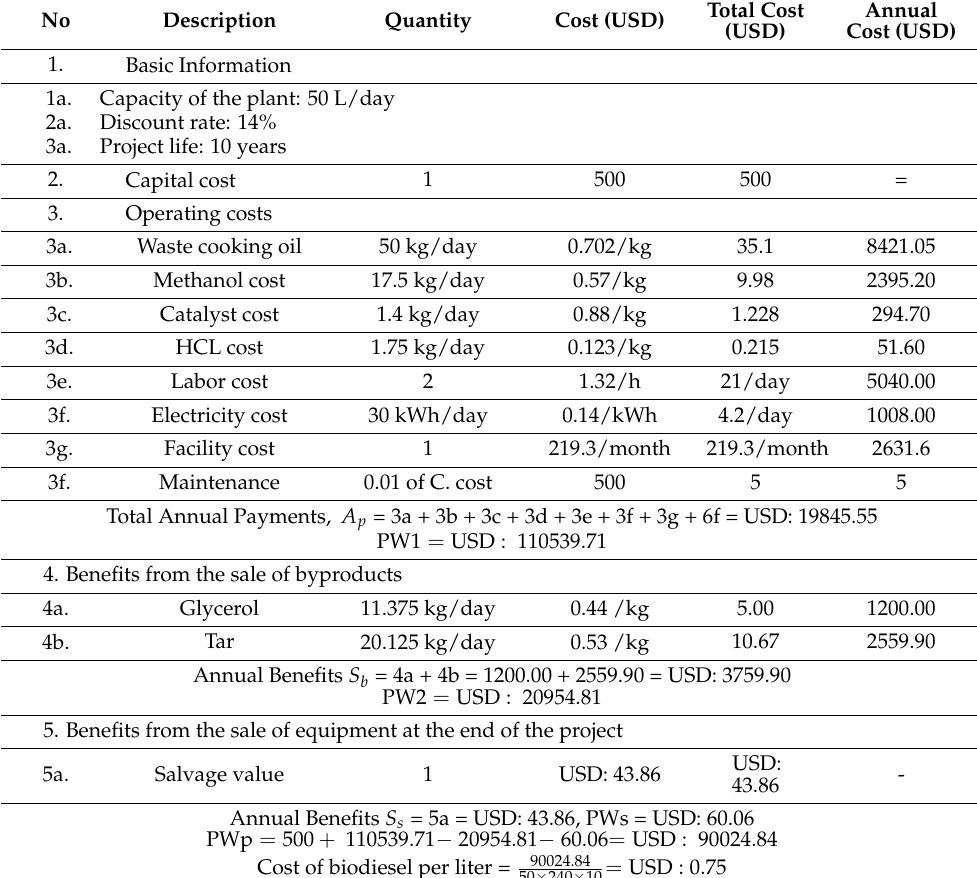
Table 4. Cost of distilled WCO-biodiesel per